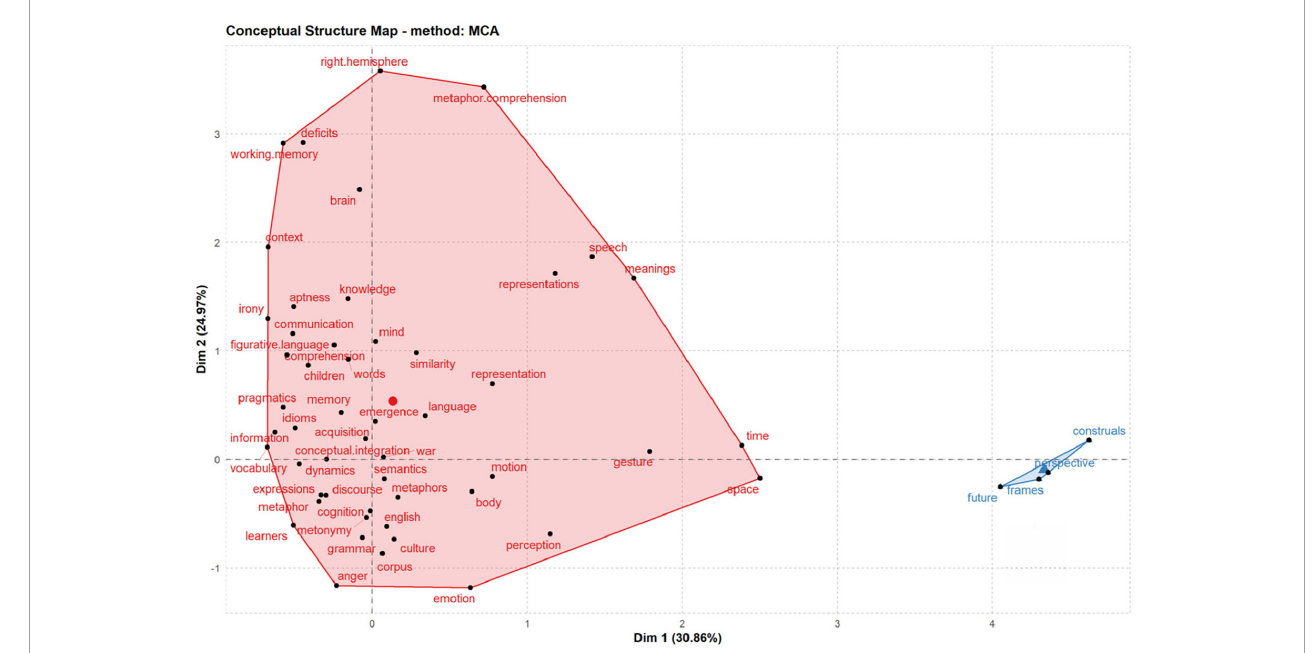
FIGURE11 Conceptual structure map. The map is split in half. Clusters are indicated by color, proximity between keywords mean their relationship, the vertex is an illustration of the term in question, and the node’s size is proportional to the frequency with which it appears.